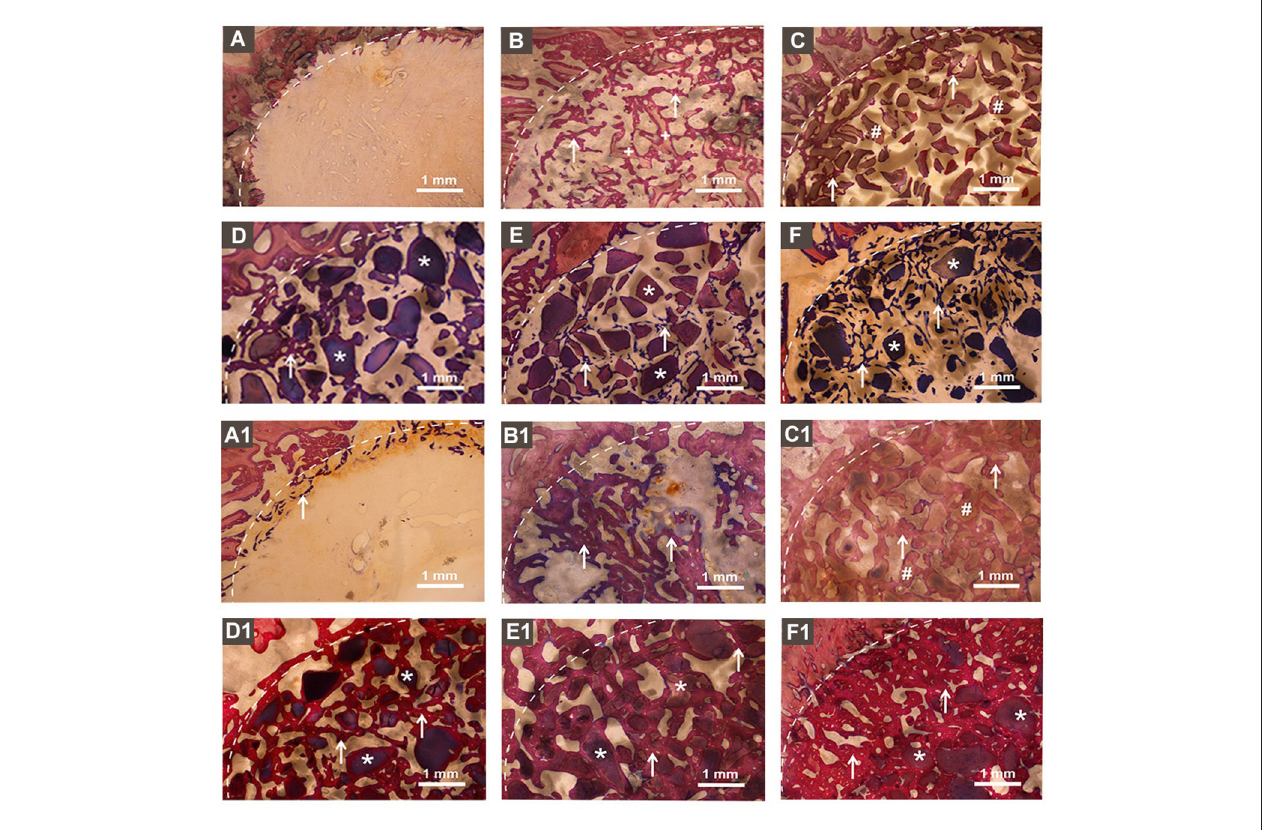
FIGURE 5 | Histological images in showing newly formed bone and remaining bone grafts. (A) no graft, (B) autologous bone, (C) DBB, (D) BioCaP, (E) BMP2-sur.BioCaP, and (F) BMP2-int.BioCaP after 4 weeks of grafting. (A1) no graft, (B1) autologous bone, (C1) DBB, (D1) BioCaP, (E1) BMP2-sur.BioCaP-group, and (F1) BMP2-int.BioCaP after 8 weeks of grafting. White dot line: demarcation between native bone and newly formed bone; white stars: remaining graft materials; + : remaining autologous bone; #: remaining DBB.